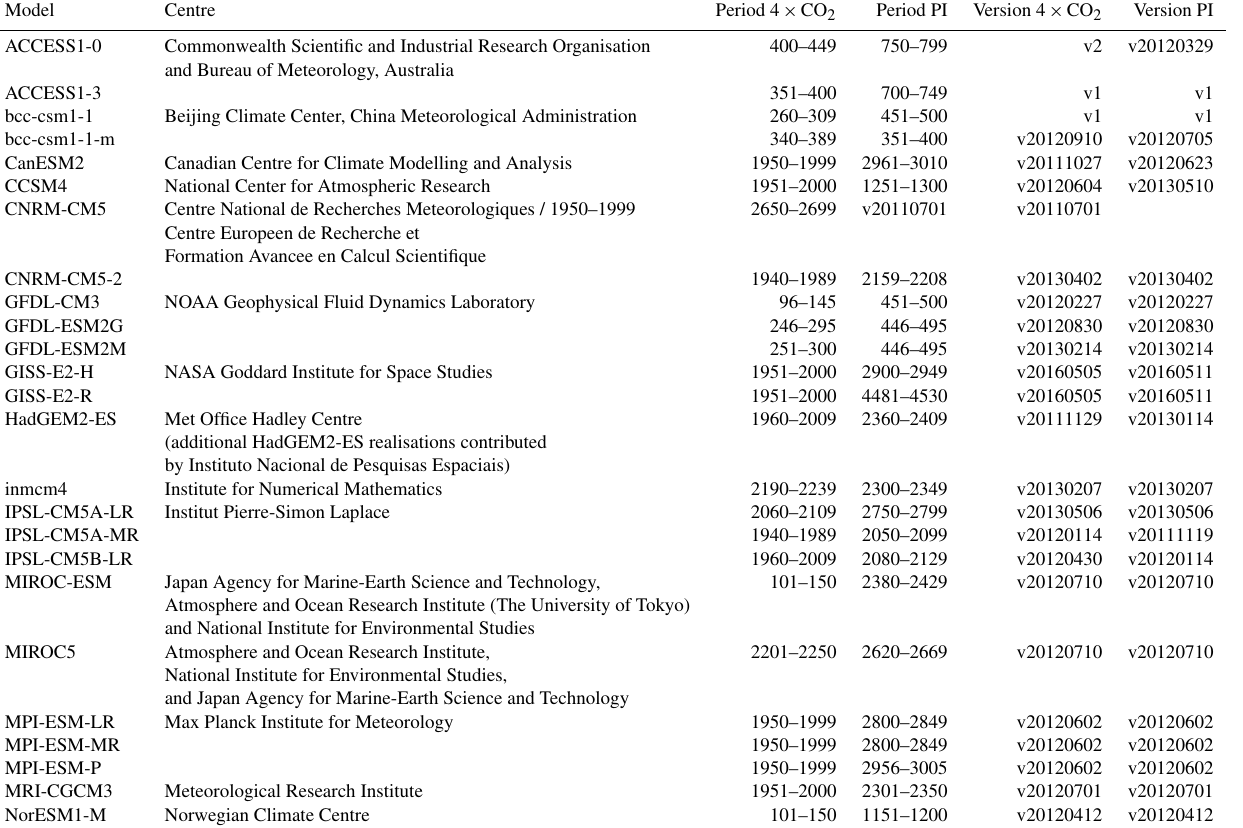
Table A1. Overview of CMIP5 model output data used in the study. Version denotes the version used of the dataset as provided by the CMIP5 data portal. Abbreviations of CMIP5 models are taken from http://cmip-pcmdi.llnl.gov/cmip5/docs/CMIP5_modeling_groups.pdf.